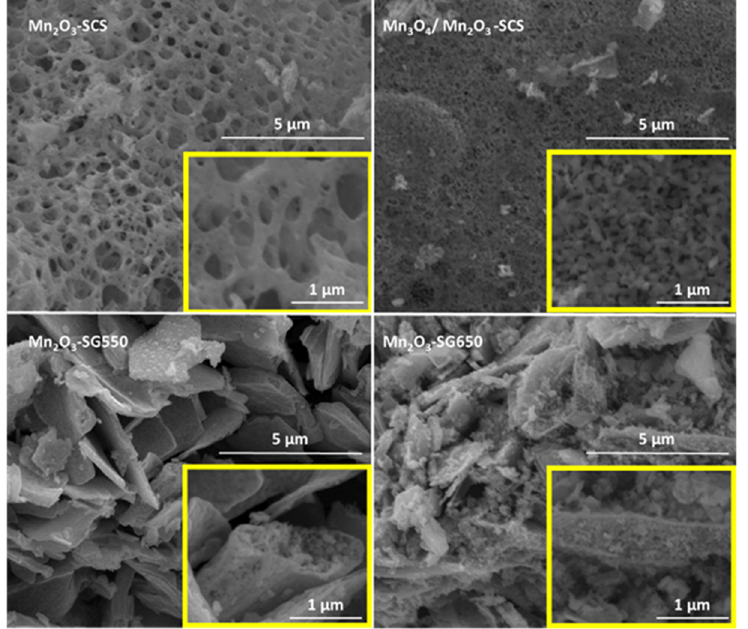
Figure 2. FESEM micrographs of the prepared catalysts and the corresponding magnifications (in the yellow frames).